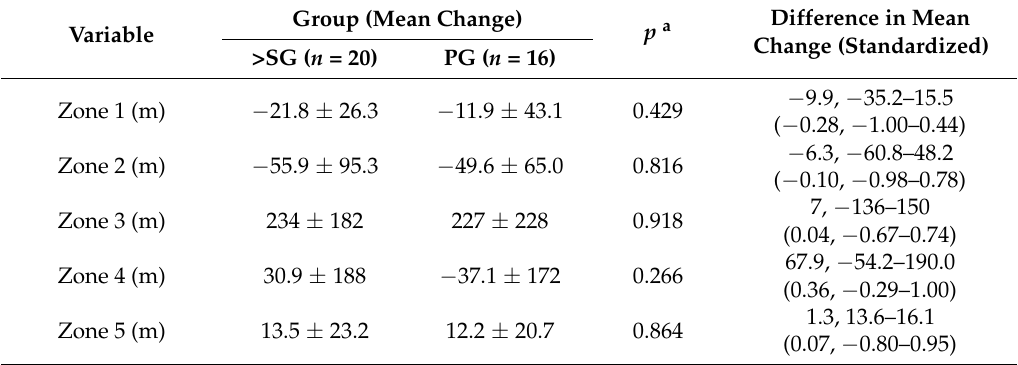
Table 3. Mean change score according to group and the difference in mean